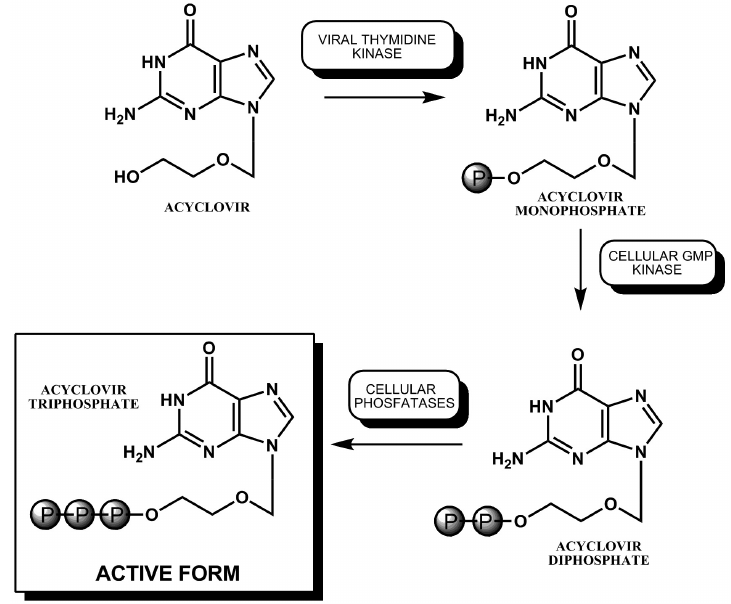
FIGURE 5 - Diagram of acyclovir bioactivation into acyclovir trisphosphate. GMP-guanosine